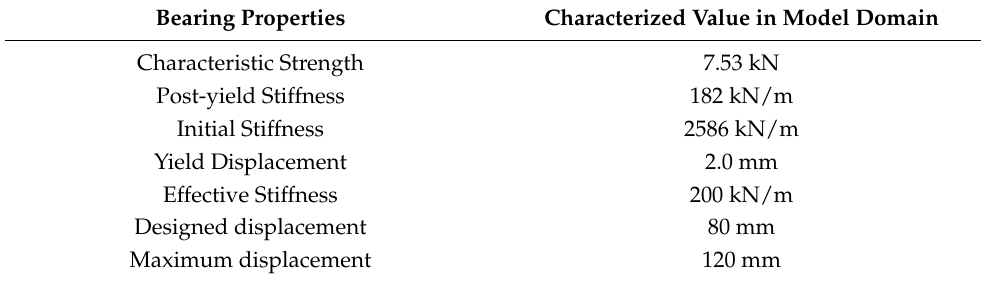
Table 2. Mechanical properties of the LNRs.